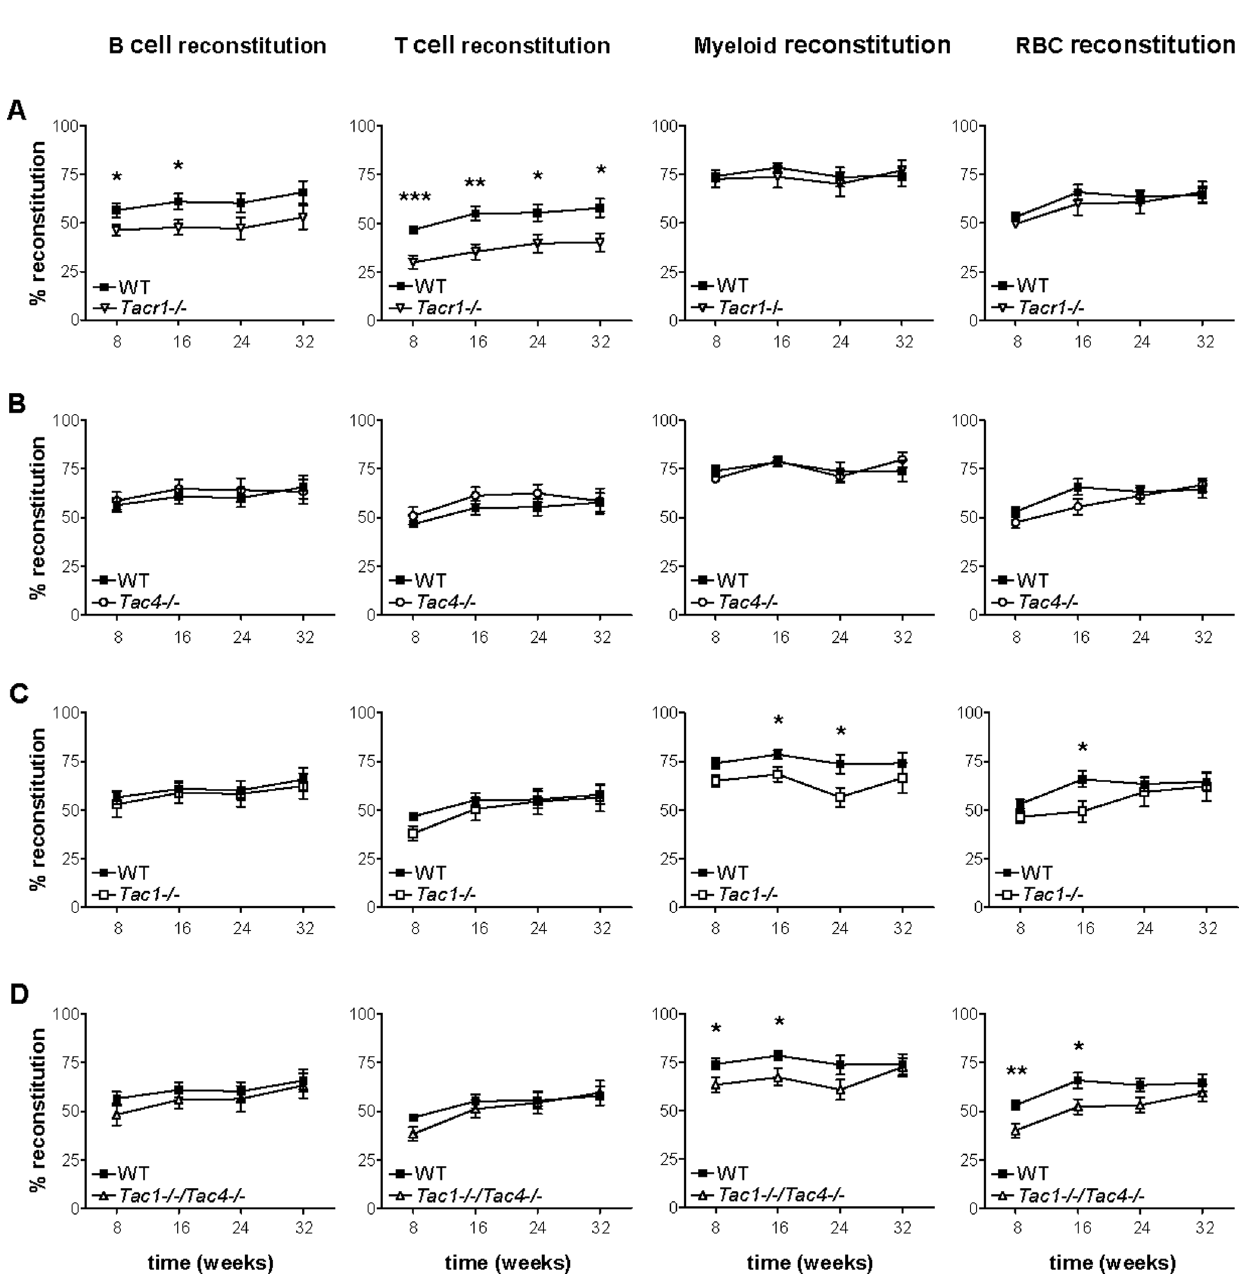
Figure 1. Analysis of the invivo reconstitution efficiency of tachykinin knockout and wild-type mice. In vivo reconstitution efficiency for (A) Tacr1 2 / 2 (NK-1R ko mice, n=10), (B) Tac4 2 / 2 (HK-1 ko mice, n=8), (C) Tac1 2 / 2 (SP/NKA ko mice, n=7) and (D) Tac1 2 / 2 / Tac4 2 / 2 (SP/NKA/HK-1 double ko mice, n=8) versus C57BL/6 mice (n=10). Each graph shows four time points (8, 16, 24 and 32 weeks) when blood was drawn to assess the donor/host reconstitution efficiency by flow cytometry. Four independent in vivo reconstitution experiments were performed and three to five individual recipient mice per strain were injected in each experiment. The results of the four experiments were pooled. Knockout mouse strains versus wild-type were analyzed at each time point separately using Student’s t-test. Time points where knockouts differ significantly from wild-type are indicated and defined as follows: * p =0.01–0.05, ** p =0.01–0.001 and *** p , 0.001.